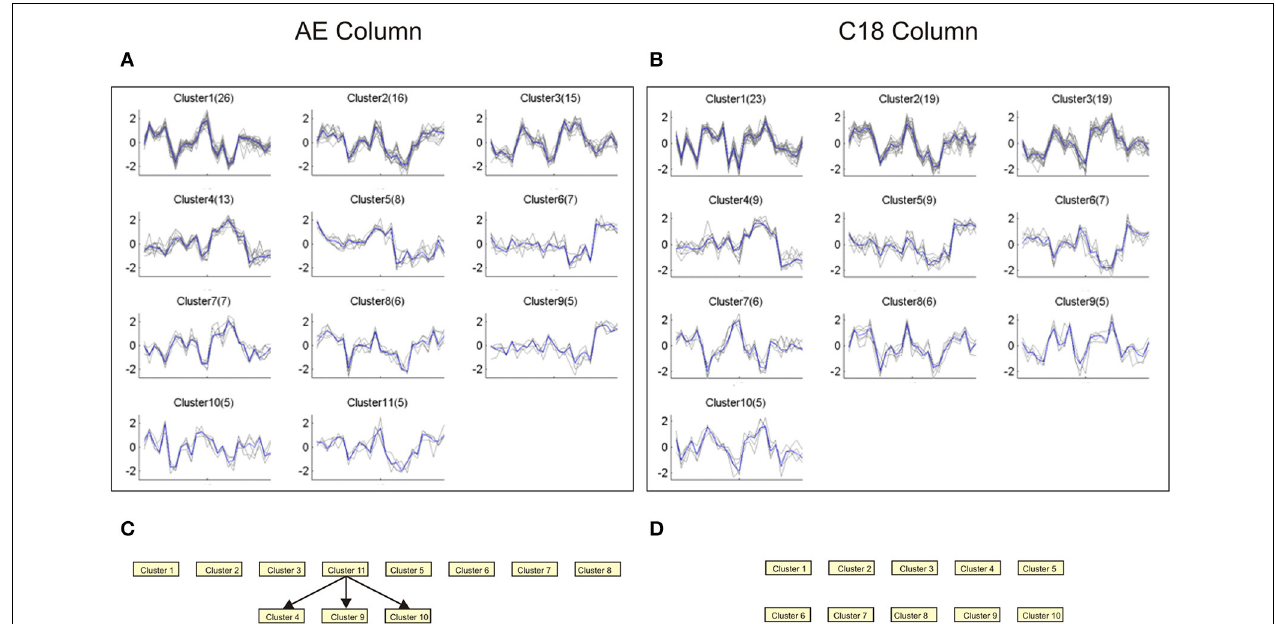
FIGURE 9 | Quality-thresholded clustering of metabolomics data. Each plot shows the standardized levels of the indicated number in parentheses of m/z features in Qt-clusters that have at least 5 features. The order of samples along the x-axis is {RCs18, RTi18, RUn18, RWr18, and RZe18} at TP3, 4, 5, 6, and 7, and the solid blue